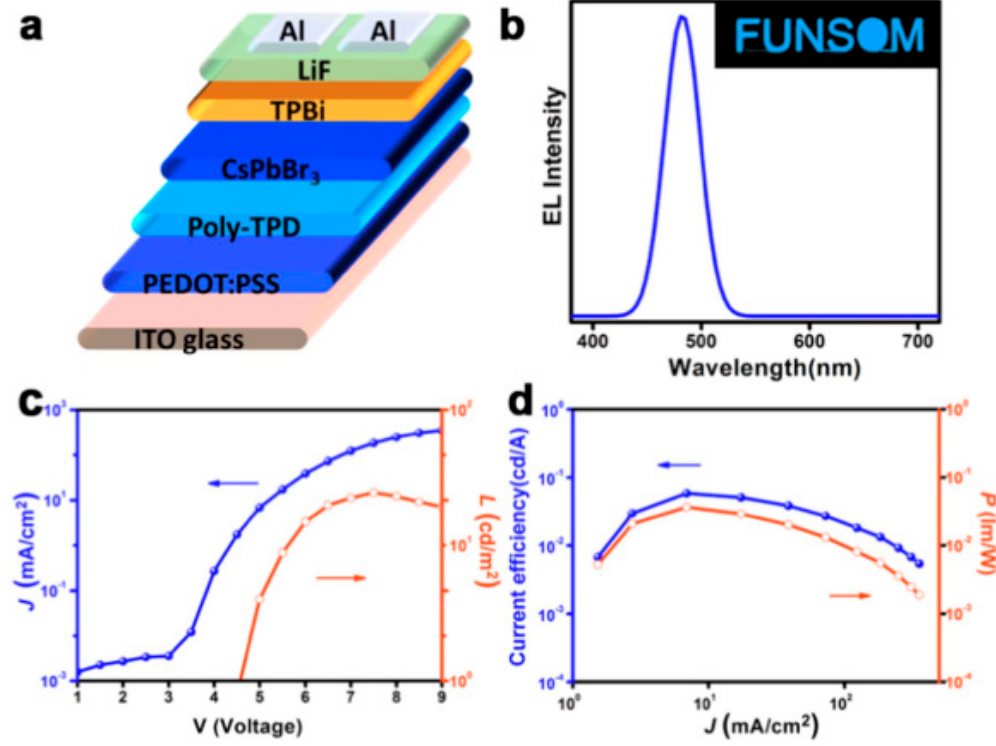
Figure 10. ( a ) The LED structure; ( b ) EL spectra. Inset: a picture of the operated LED; ( c ) Current density (J)-Voltage (V)-Luminance (L) curves; ( d ) Current efficiency-J-Power efficiency (P) curves. Adapted from [155], with permission from © 2018 Elsevier.